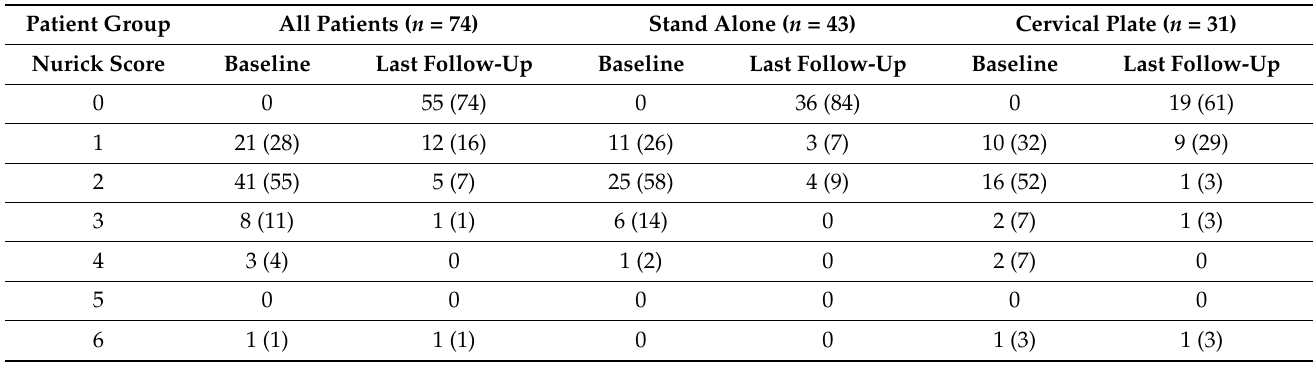
Table 3. Surgery Outcomes for Myelopathy and Myeloradiculopathy Cohorts.